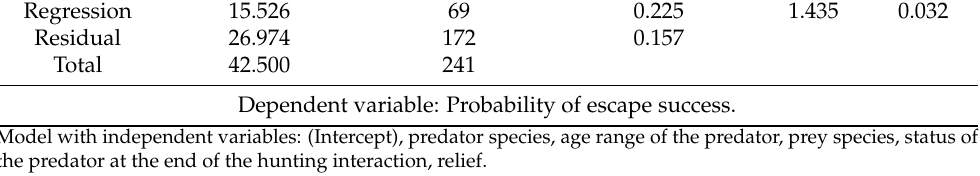
Table 10. Summary of results for the Bayesian ANOVA approach for the model predicting the probability of successful dam escape including factors for which a significant effect had been detected. Degrees of Source Sum of Squares Medium Square F p -Value Freedom Regression 15.526 69 0.225 0.032 Residual 26.974 172 0.157 Total 42.500 241 Dependent variable: Probability of escape success.